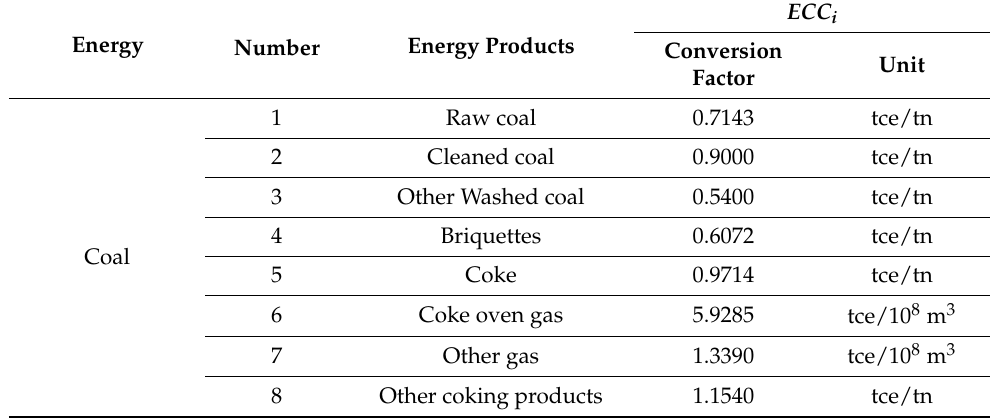
Table A1. Conversion factors of each energy source type based on tons of coal equivalent